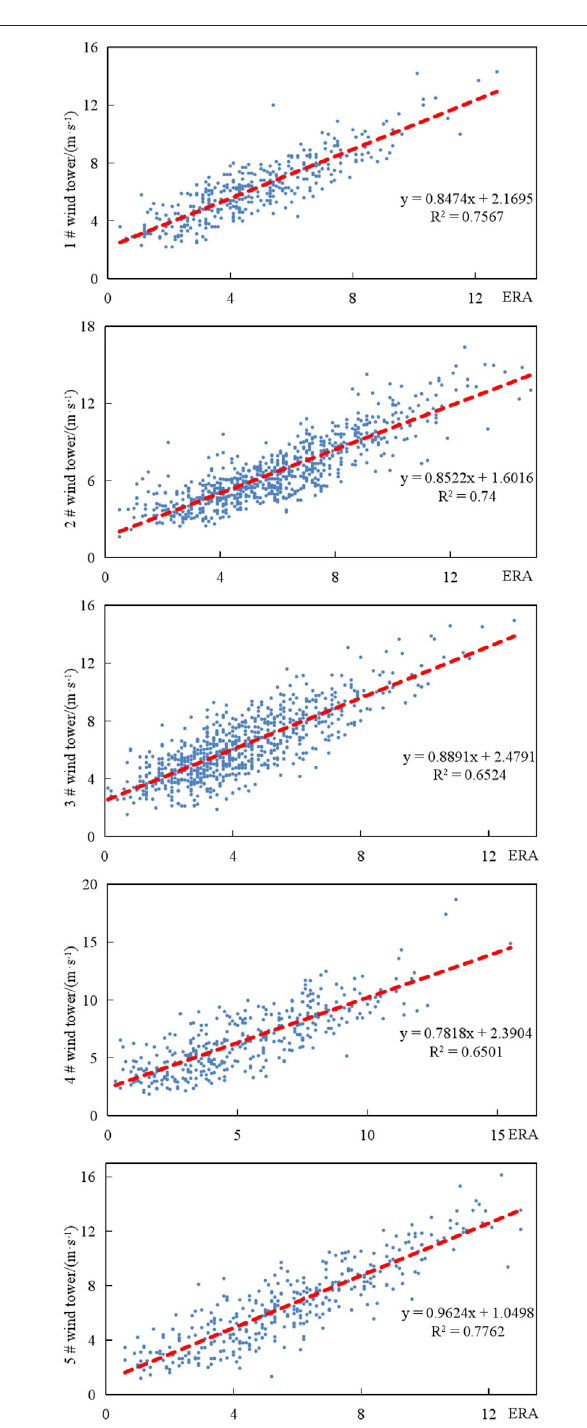
FIGURE 2 | The relevant information between measured wind speed andreanalysisdataofERA-Interim(units:m · s − 1 ).Thebluepointrepresentsthe wind speed, the red dotted line represents the linear trend.